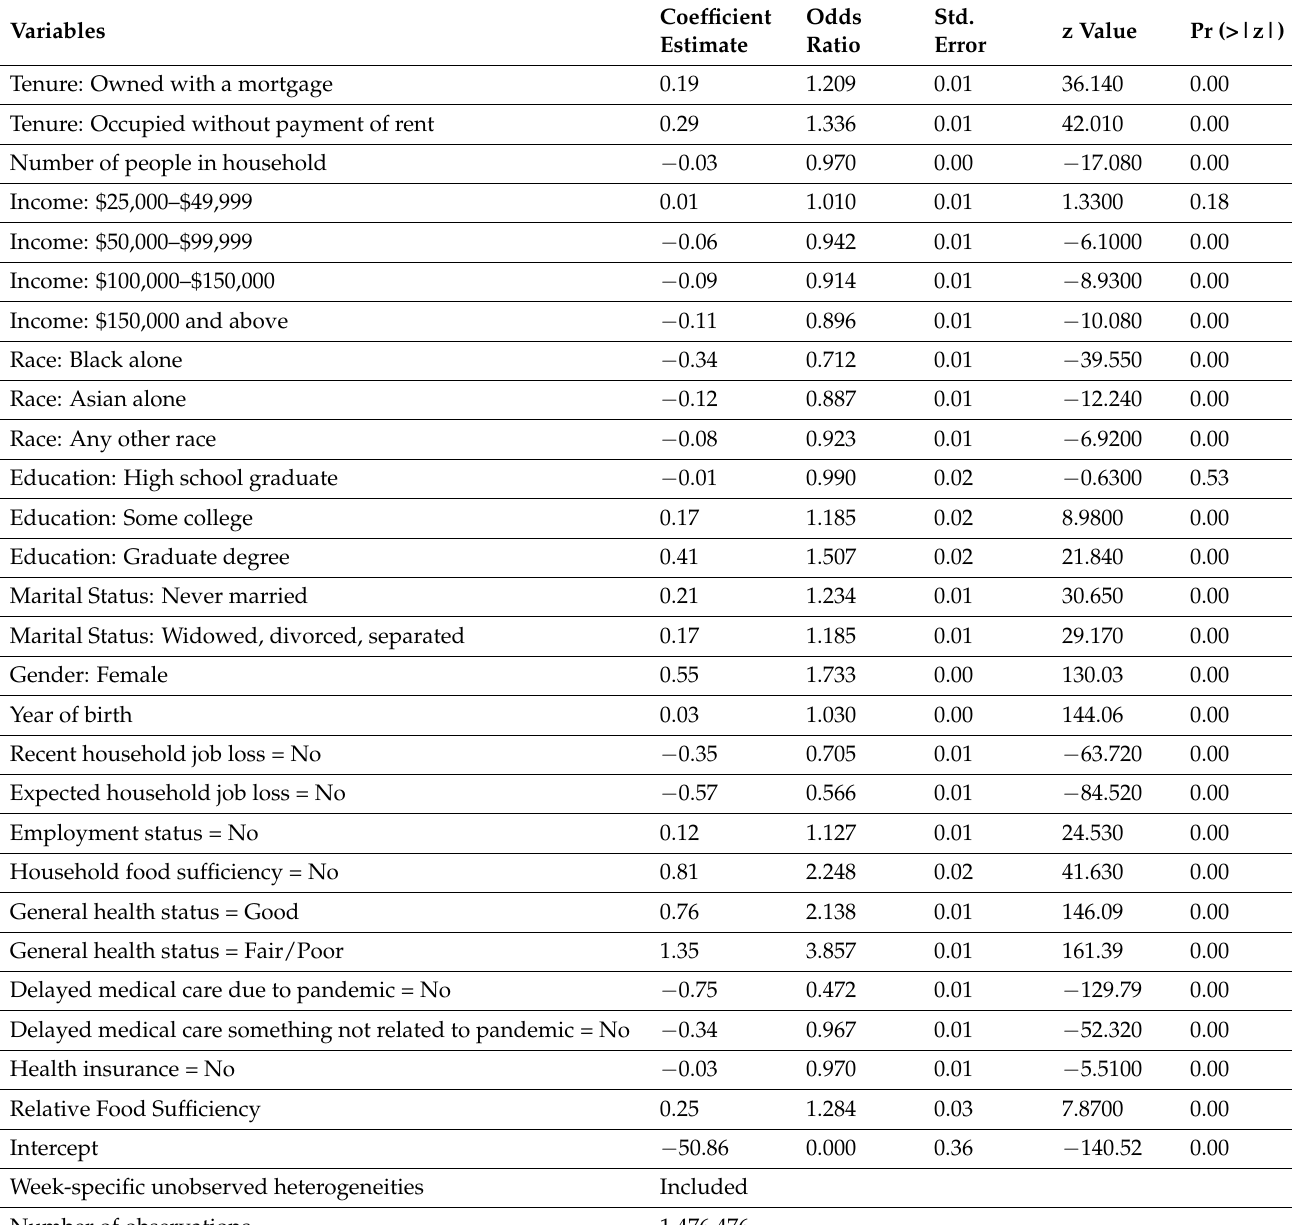
Coefficient Estimate